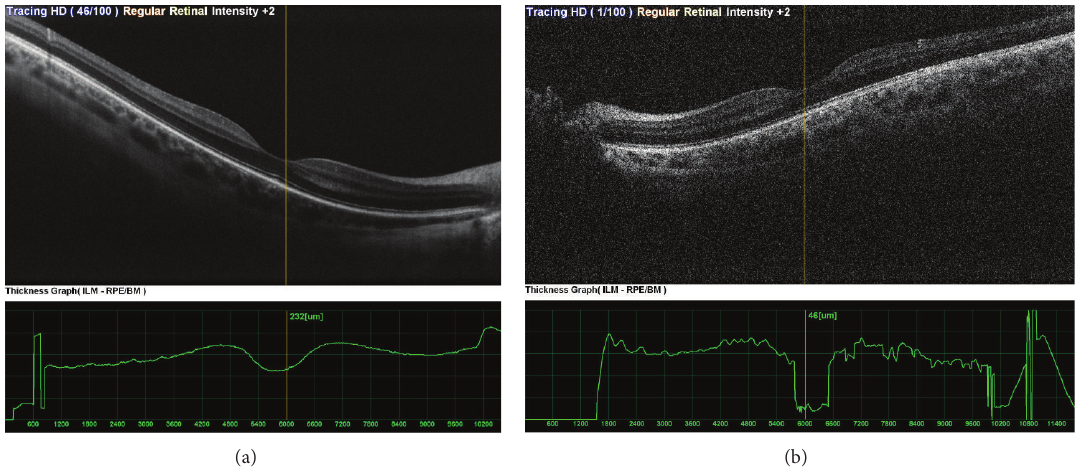
Figure 5: Macular measurements were within normal limits in the right eye (a) and in the left eye (b).